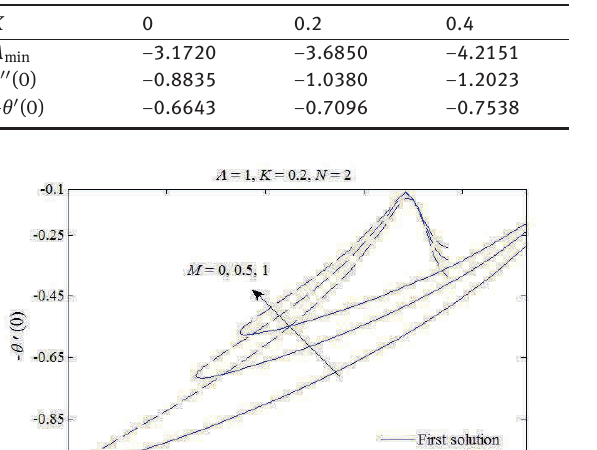
Table 2: Values of A min for different values of K when Λ = 1, M = 0.5, N = 2 .